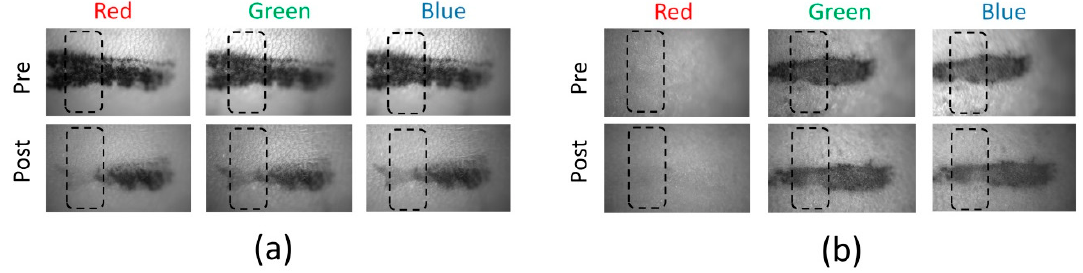
Figure 2. CMOS images of ( a ) black and ( b ) red tattoo pre- and post-laser treatment under various LED colors (red, green, and blue lights): Each black dotted box represents a region for image analysis.